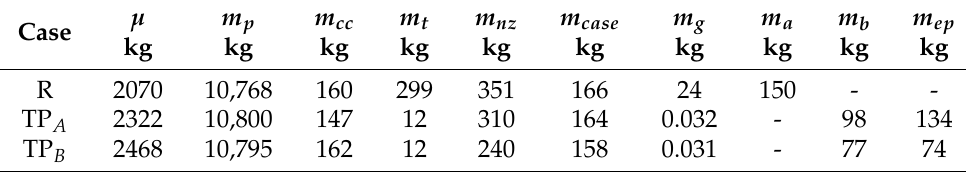
Figure 3. Thrust and mixture ratio histories for blow down, regulated and pump-fed optimized solutions. Table 2. Mass budget comparison. The first column reports the feed system employed: regulated (R) or turbo-pump (TP). (A) and (B) refer to the electrical properties used in the mass evaluation (see Table